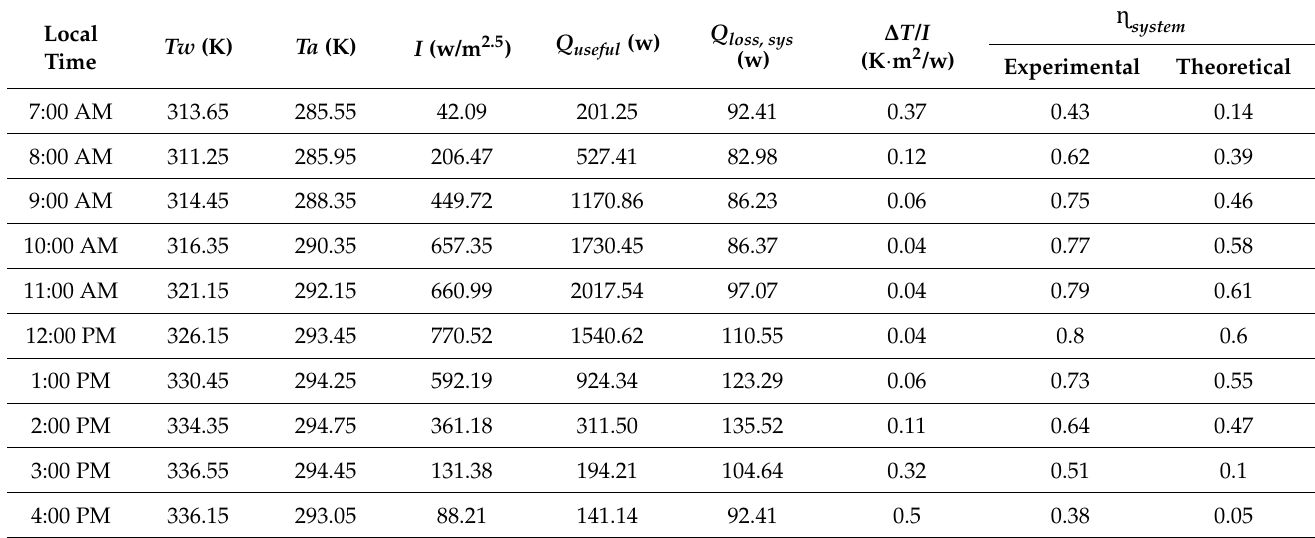
Table 3. Experimental and calculated results for December 2021 with paraffin. Table 5. Experimental and calculated results for June 2022 with paraffin.